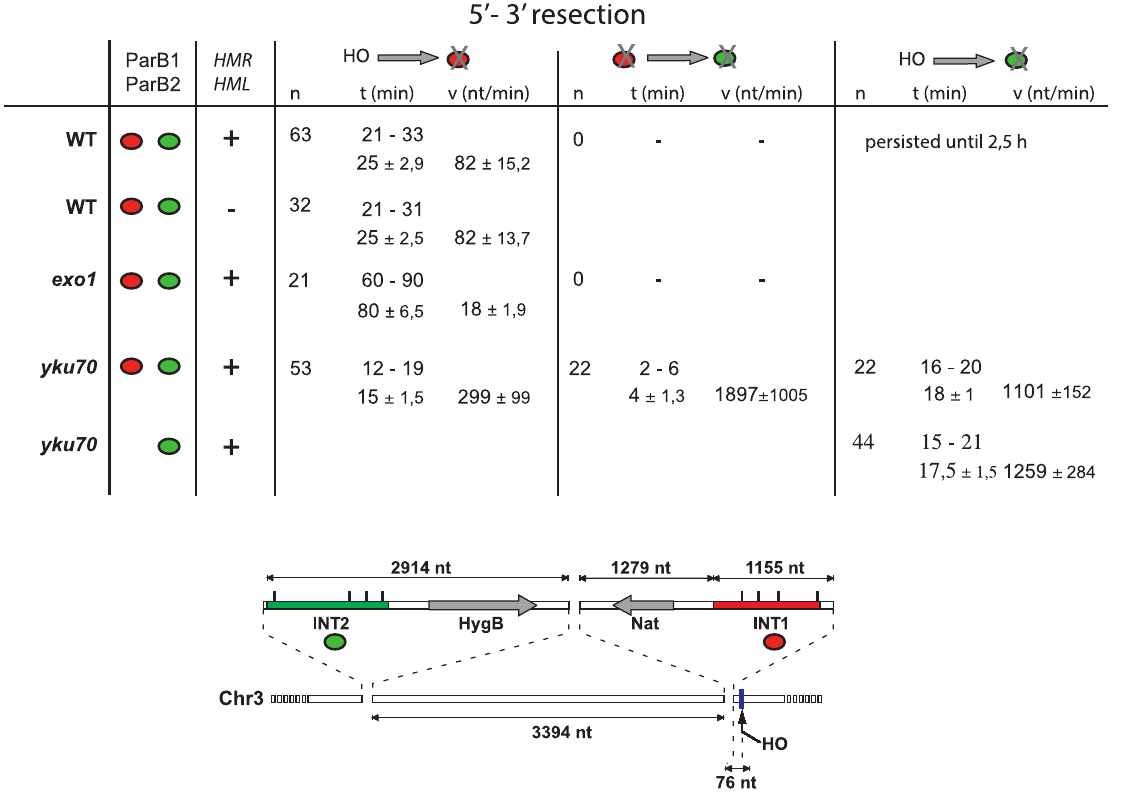
Figure 2. Chromosome dynamics during DNA resection in single yeast cells. A : Time-lapse fluorescence microscopy showing ParB1::mCherry-INT1 and ParB2::GFP-INT2 foci after induction of HO synthesis. Both signals persisted during acquisition periods of . 60 min ( . 1500 exposures), with minimal bleaching. Representative single plane images are shown. B : Growth on YPE-D and YPE-Gal of wt and mutant strains bearing or not pGal-HO or ParB expressing plasmids as indicated. Cells were incubated 24 h or 48 h at 30 u C and plated in 10 6 dilution increments. C : Fluorescence intensity quantification during resection in representative cells of wt, yku70 and exo1 strains. Intensity ratios are calculated relative to adjacent background levels. Background bleaches rapidly during initial acquisition, increasing the signal ratio. D : Time course of resection in wt and yku70 cells, measured as percentage of fluorescent INT1 and INT2 foci newly disappeared at each time point. No INT2 resection was detected in wt cells within the time of the experiment.